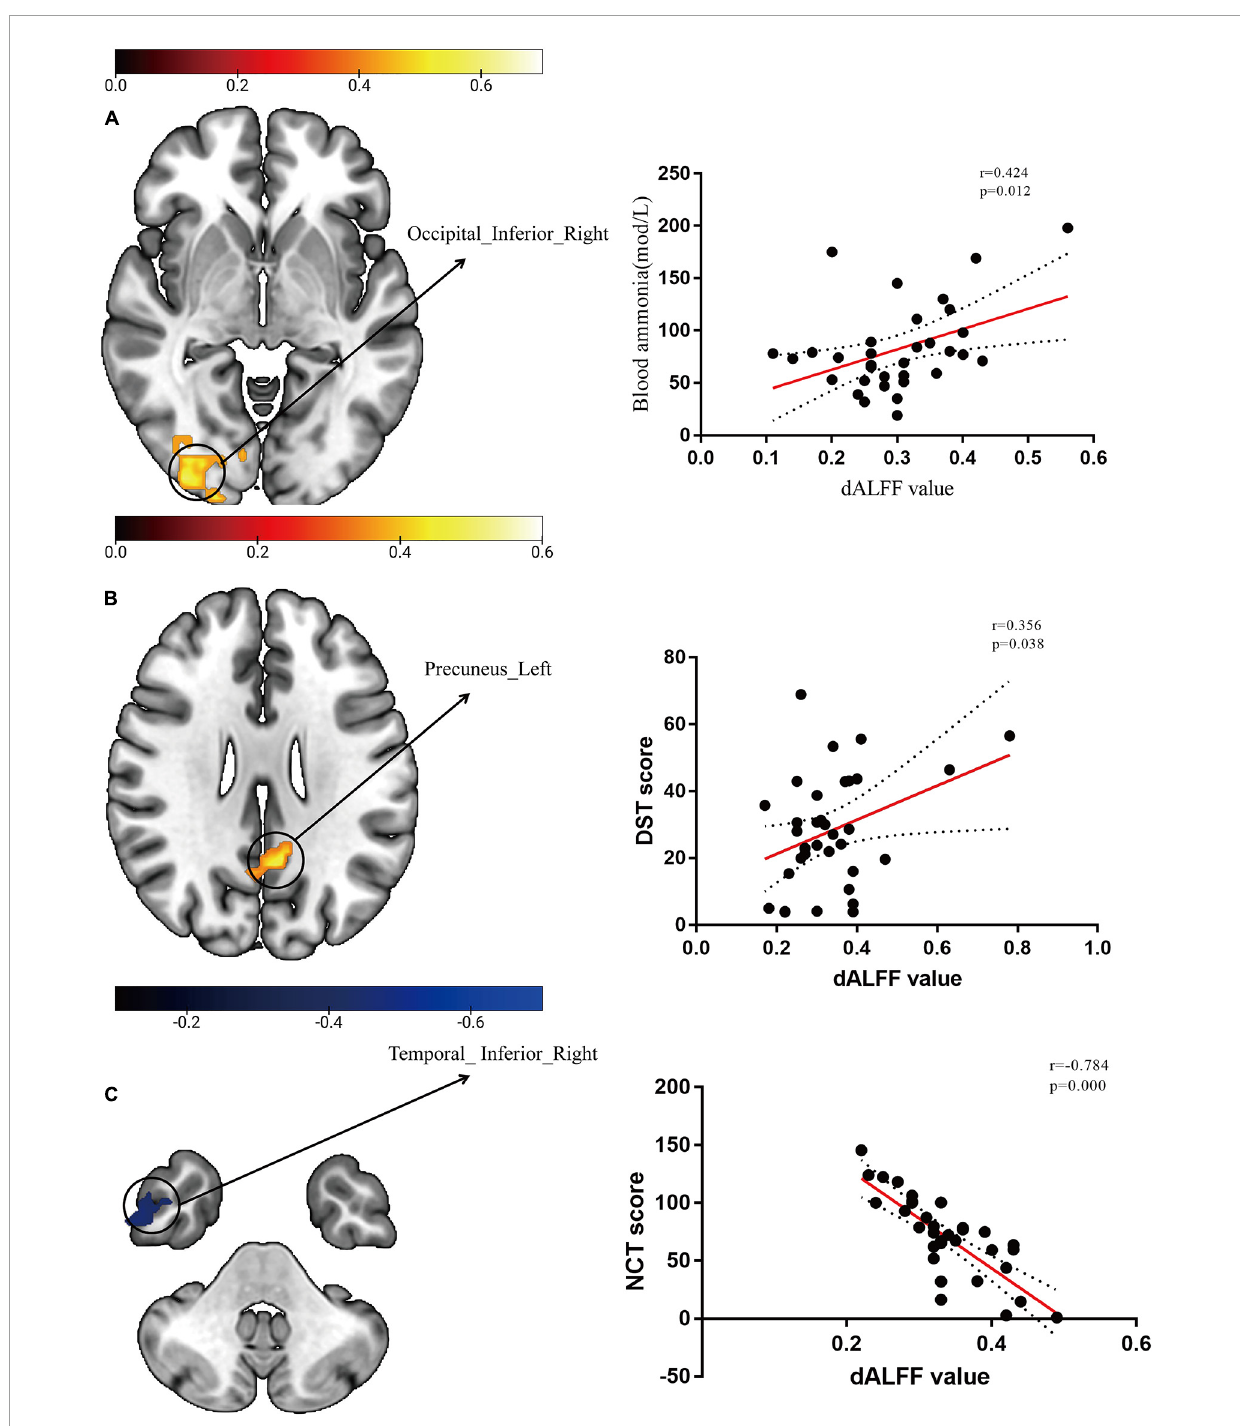
FIGURE2 Scatter plots of dynamic amplitude of low-frequency fluctuation (dALFF) with blood ammonia levels and neuropsychological scores. (A) The temporal variability of dALFF in the right IOG was positively correlated with blood ammonia levels (r = 0.424, p = 0.012, uncorrected). (B) The temporal variability of dALFF in the left precuneus gyrus was positively correlated with digit-symbol test (DST) scores (r = 0.356, p = 0.038, uncorrected). (C) The temporal variability of dALFF in the right inferior temporal gyrus (ITG) was negatively correlated with number connection test–A (NCT-A) scores (r = -0.784, p = 0.000,